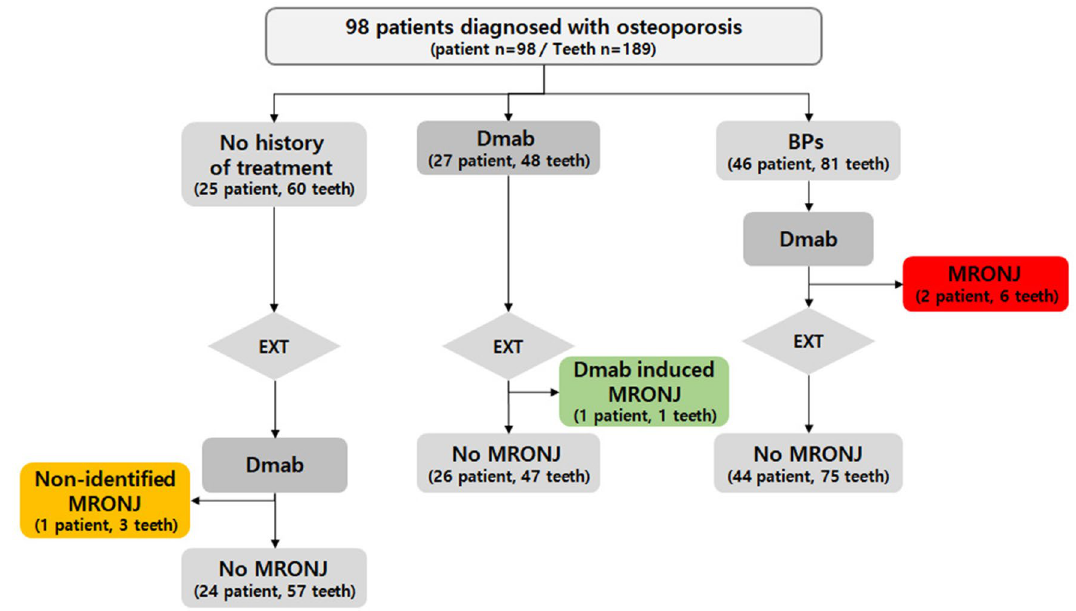
Figure 1. Flow of MRONJ occurrence. Drug administration and MRONJ route before and after tooth extraction in 98 patients diagnosed with osteoporosis. Four patients developed MRONJ. In two of these patients, MRONJ occurred after administration of bisphosphonate and denosumab and before extraction. One patient received denosumab only and developed MRONJ after tooth extraction. The remaining one patient had undergone extraction without prior osteoporosis treatment, and then MRONJ developed after administration of denosumab. BP bisphosphonate, Dmab denosumab, EXT extraction, MRONJ medication-related osteonecrosis of the jaw. The dotted line represents the MRONJ flow.